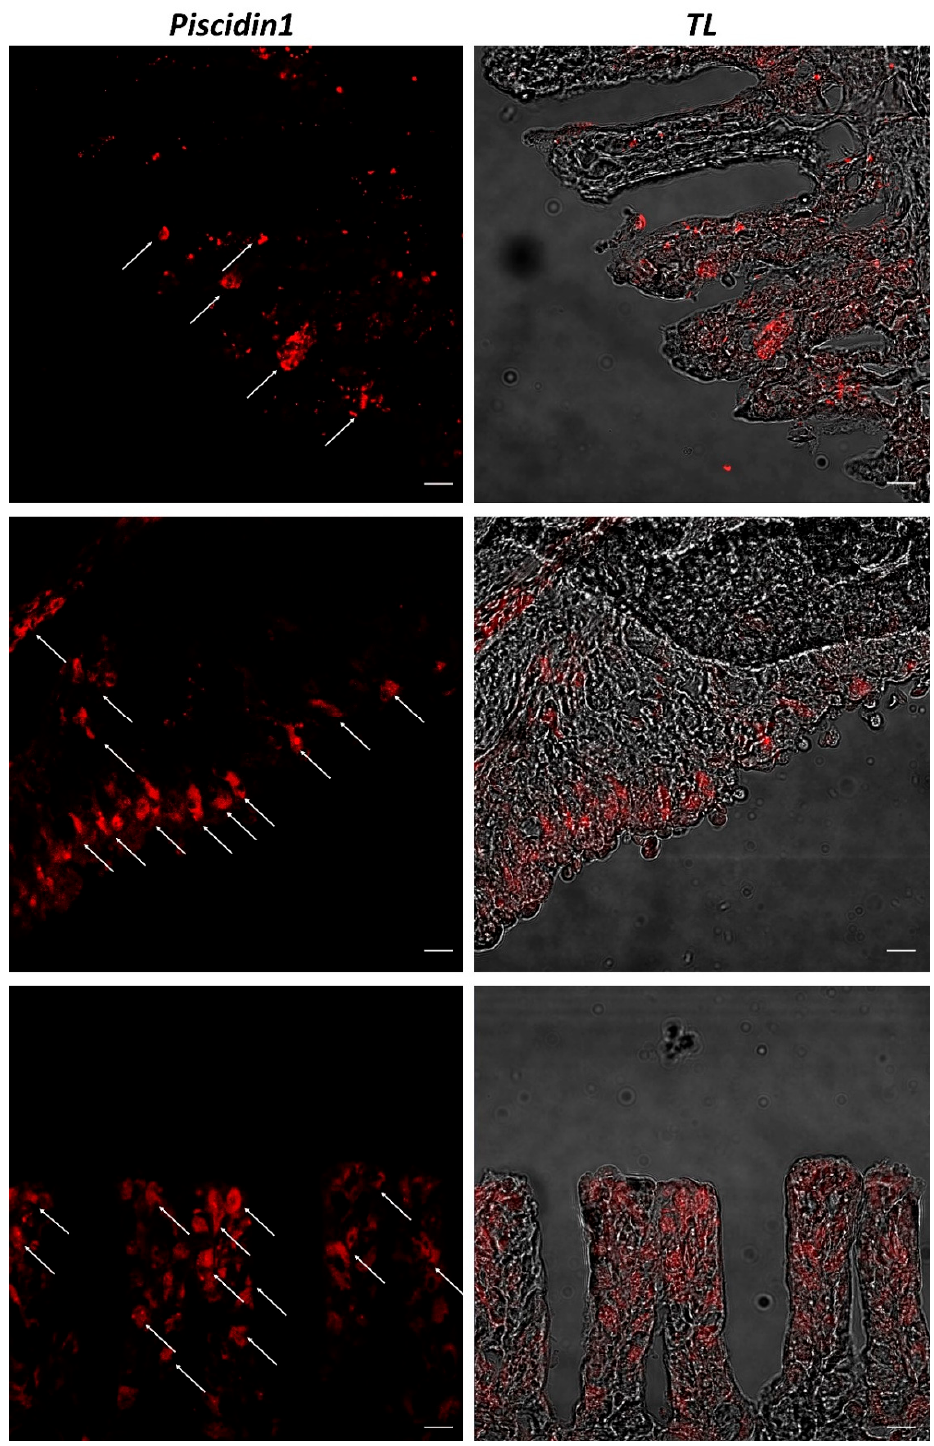
Figure 3. Section of the gill of giant mudskipper, immunofluorescence, 20×, scale bar 20 μ m. MCs immunoreactive to Piscidin1 can be noted (arrows). TL = transmitted light.